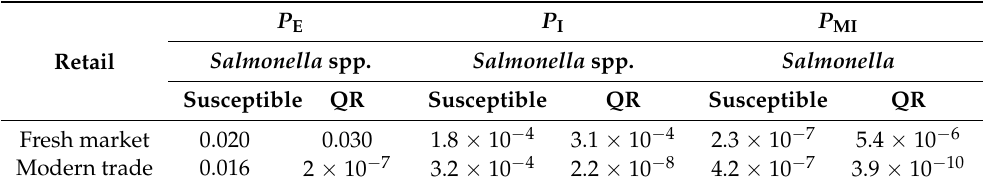
Table 3. Probabilities of exposure ( P E ), illness ( P I ), and mortality given illness ( P MI ) from susceptible and QR Salmonella spp.